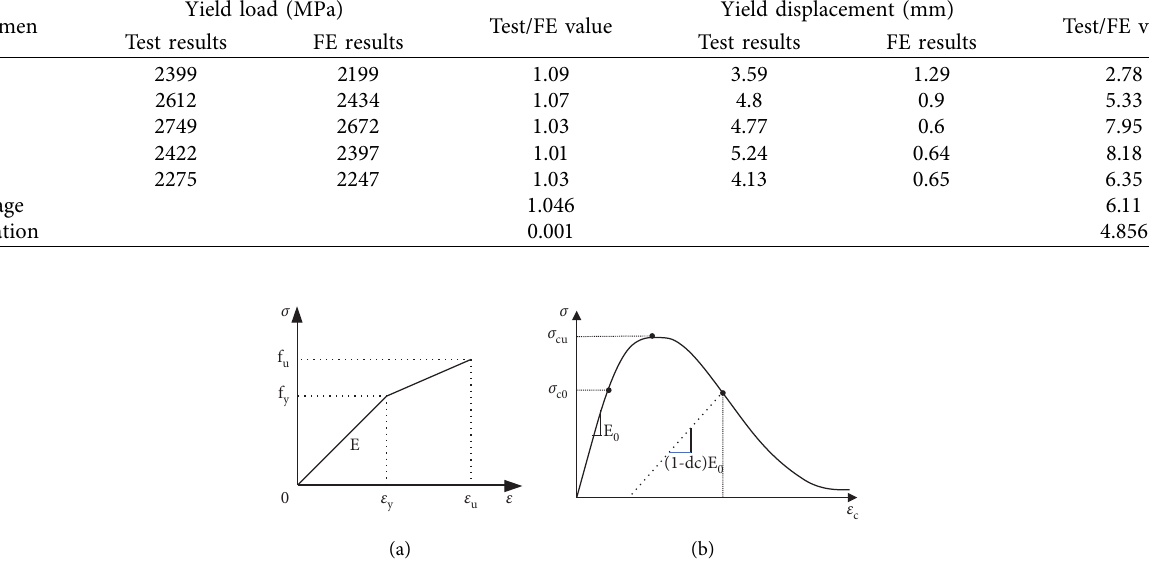
Figure 8: Stress-strain relationship of the materials. (a) Steel tube and (b) microexpansive concrete.